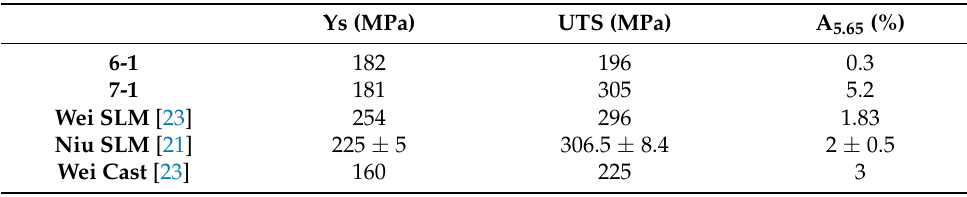
Table 7. Results of tensile test performed at room temperature for AZ91D.